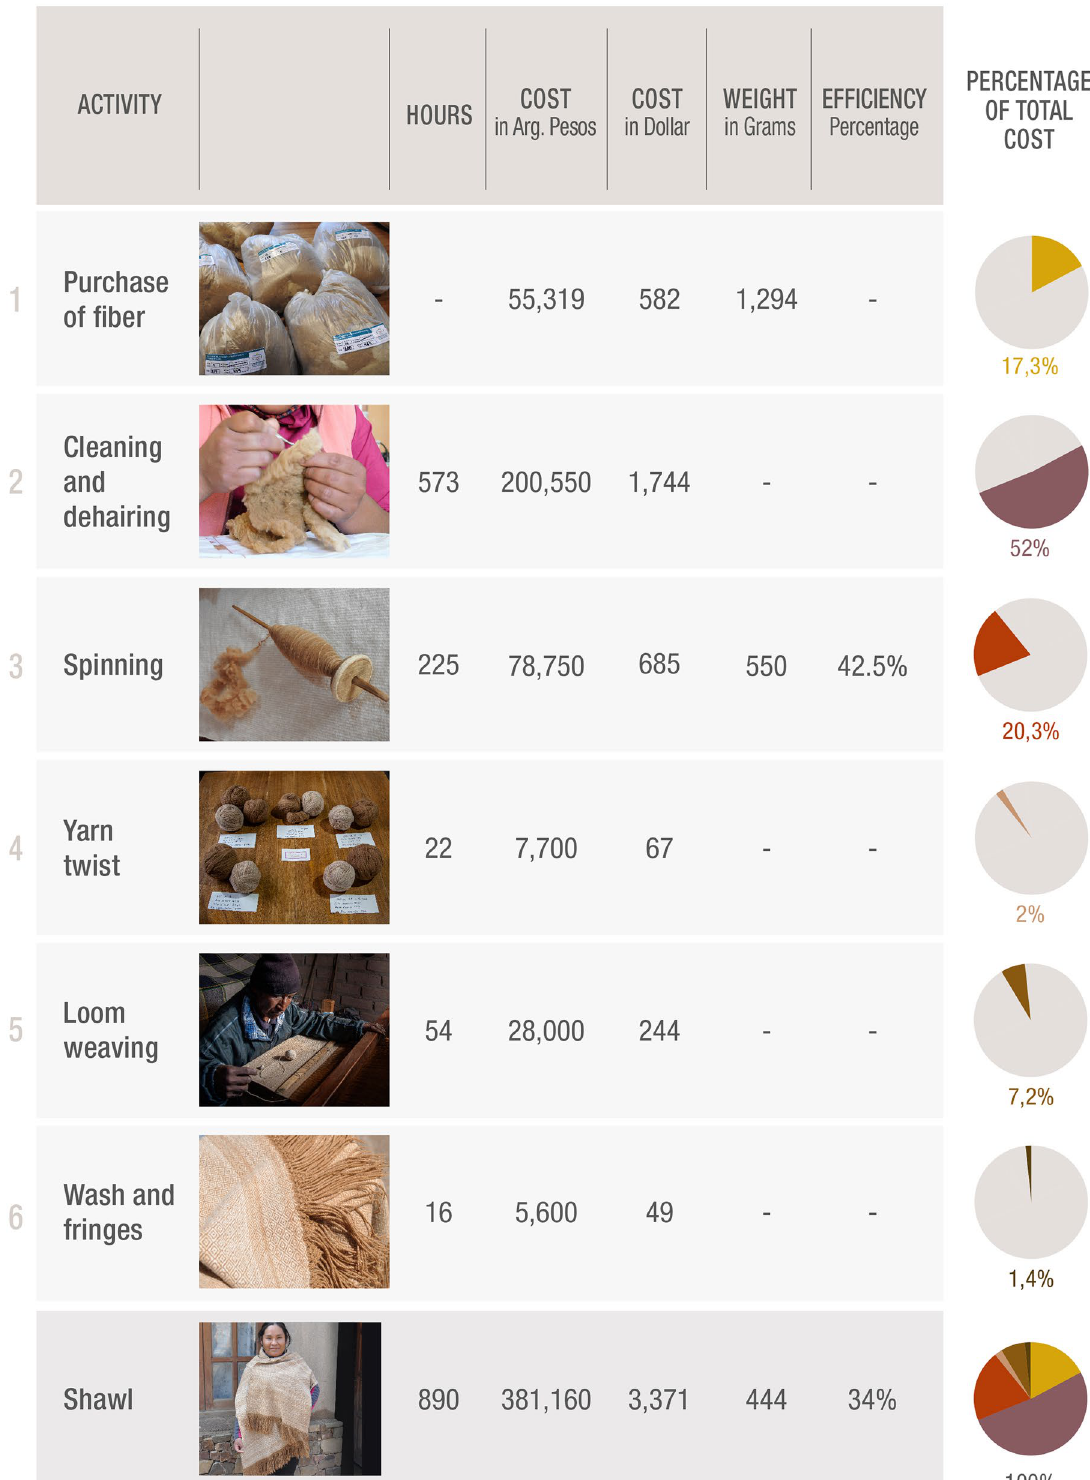
Table 1 Description of the steps from vicuñas raw fibre to a shawl, including images of the activities, number of total hours, the cost in pesos and dollars (please observe that the rate in the purchase of the fibre was that one at that date 95 pesos per US dollar, while the rate for the rest of the table is the current while writing the paper 115 pesos per US dollar). Photograph credits: Silvina